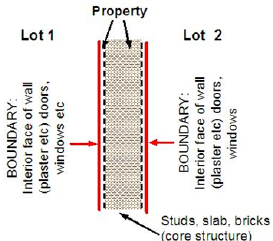
Figure 1. Interior boundaries defined by referencing a wall